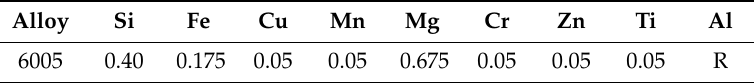
Table 1. Composition of the investigated alloy [%].